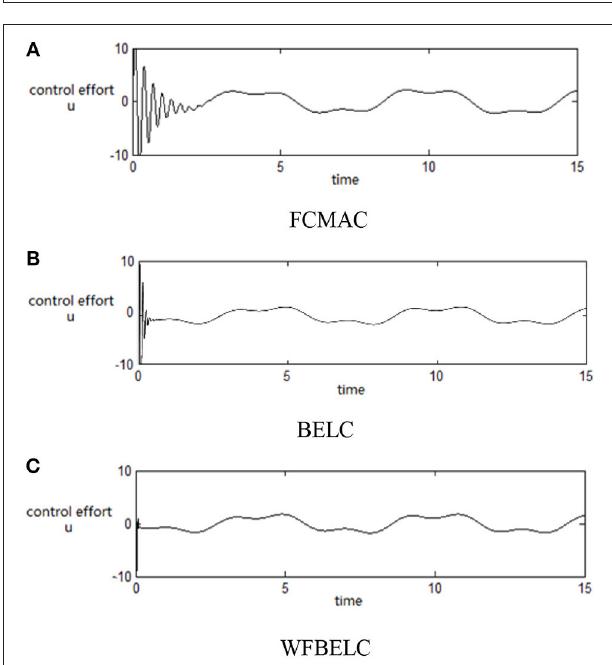
FIGURE 6 | Response tracking curves of state x 2 ( q = 0.3) (A) FCMAC, (B) BELC, and (C) WFBELC.